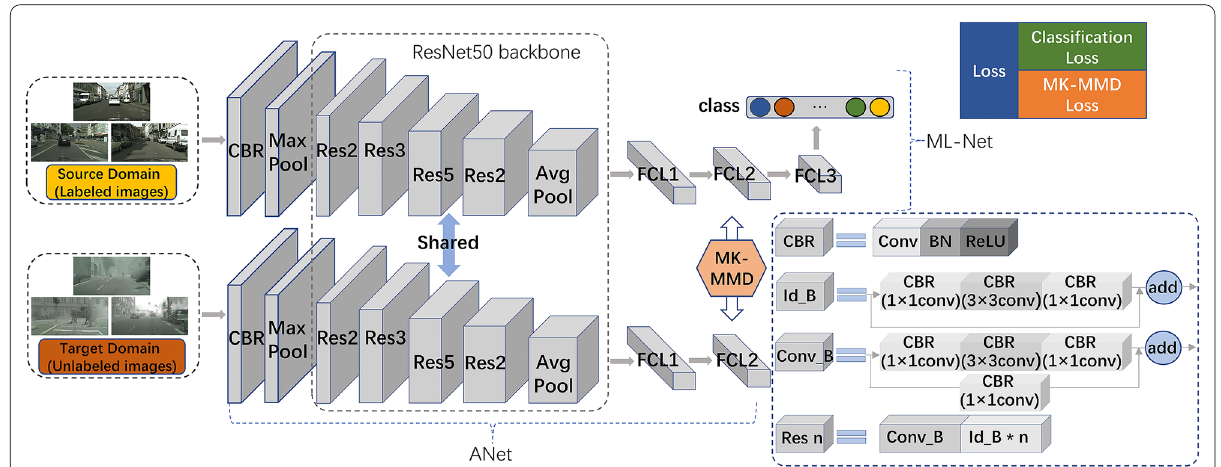
Figure 1 The overall framework of our proposed